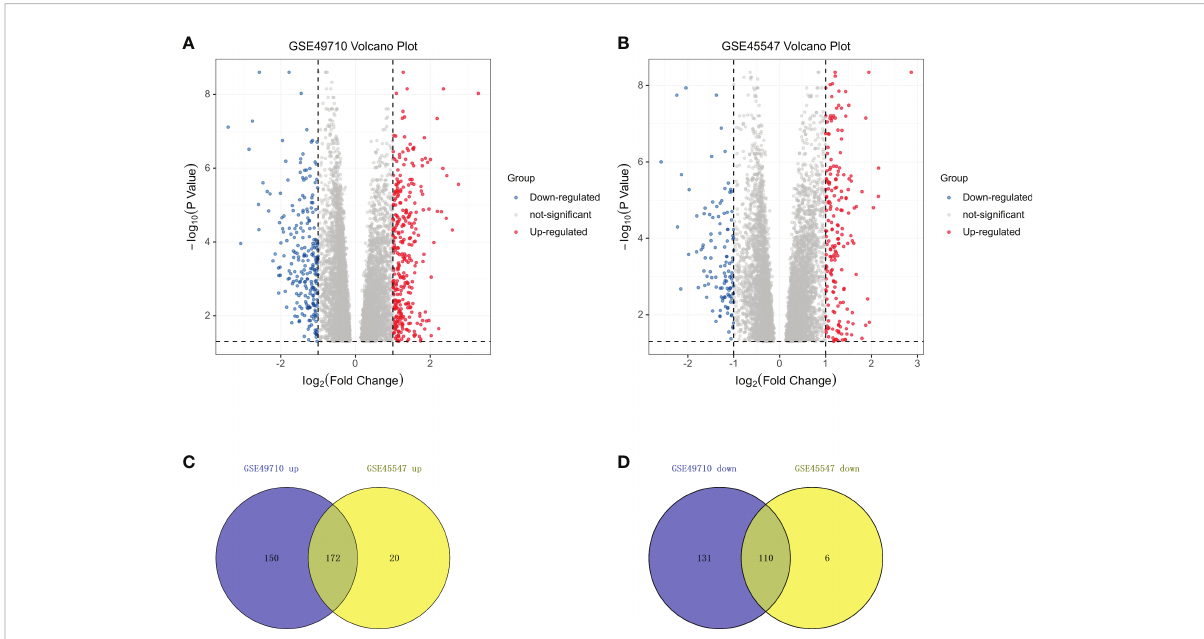
FIGURE 1 DEGs in two datasets from the GEO. (A) Volcano plots showing the DEGs in GSE49710. (B) Volcano plots showing the DEGs in GSE45547.The red dots represent upregulated genes, blue dots represent downregulated genes, and gray dots indicate genes with no signi fi cant differences. (C) Venn diagram showing the intersection of upregulated genes. (D) Venn diagram showing the intersection of downregulated genes. All DEGs are screened based on an Adjust P value < 0.05 and |Fold Change| >